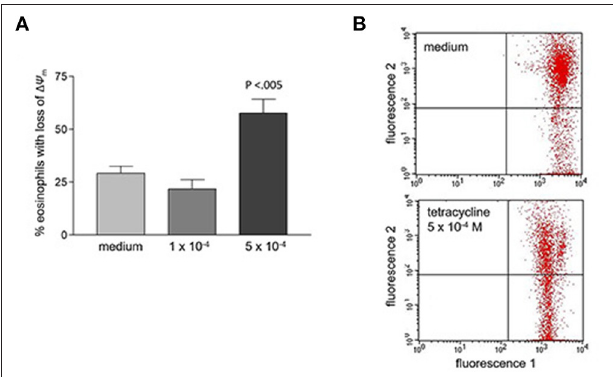
FIGURE 3 | Loss of mitochondrial membrane potential ( 19 m ) after 48h stimulation with tetracycline hydrochloride. (A) Percentage of eosinophils with loss of 19 m cells is significantly increased after 48h stimulation with 5 × 10 − 4 M tetracycline hydrochloride compared to medium ( p < 0.005, n = 5). (B) Representative dot plot (five independent experiments) of red fluorescence 2 vs. green fluorescence 1. Compared to medium stimulation with tetracycline hydrochloride 5 × 10 − 4 resulted in a significant loss of 19 m . Live cells with intact 19 m are in the upper right quadrant, apoptotic cells with decreased fluorescence 2 are in the lower right quadrant (loss of 19 m